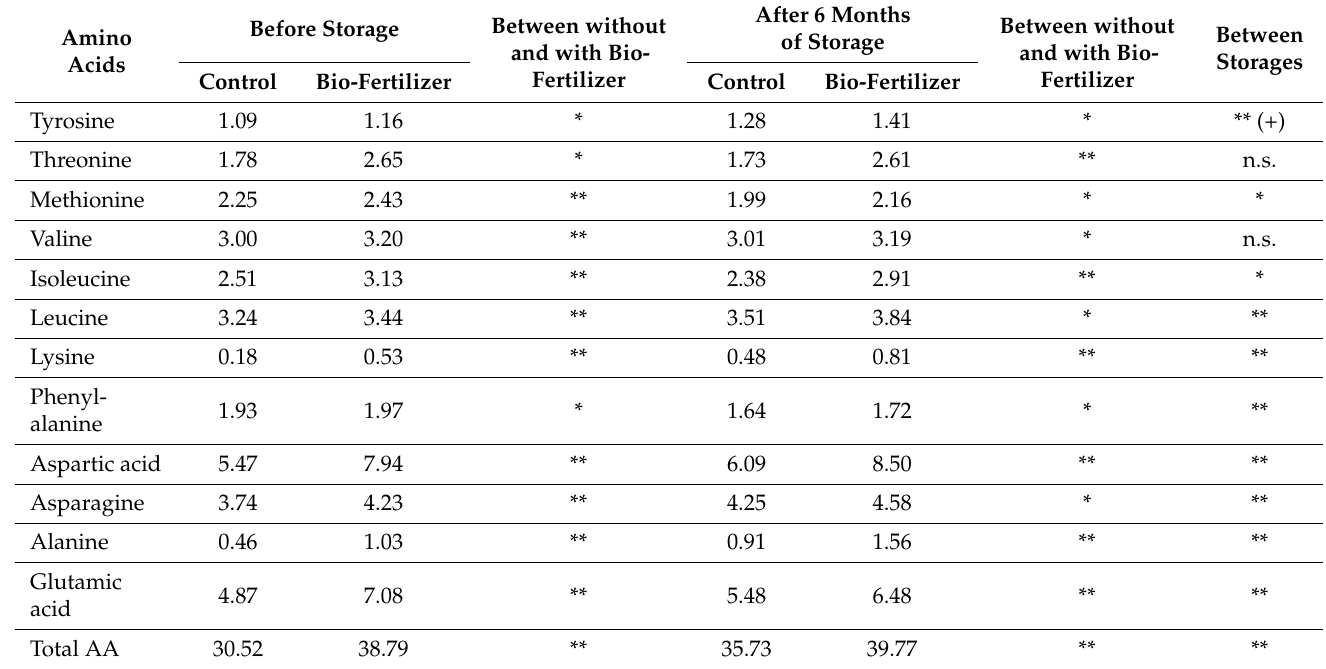
Table 13. Effect of bio-fertilizer and storage on the amino acid composition of potato tubers (g 100 g − 1 protein) (mean from 3